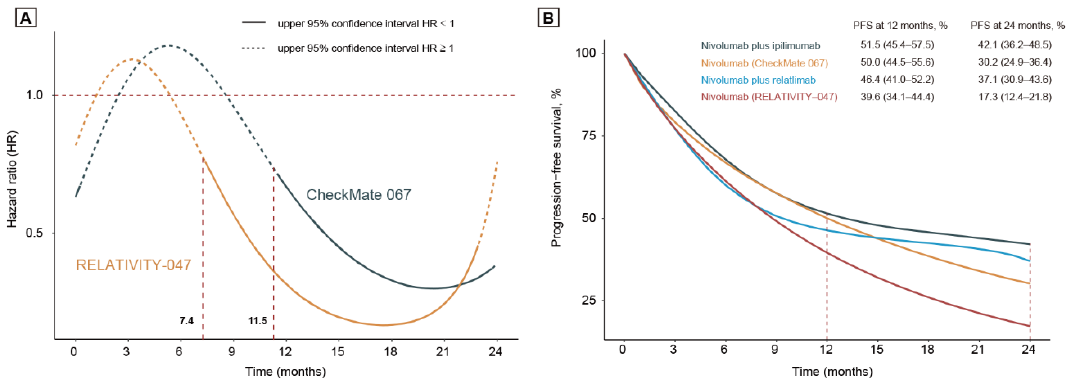
Figure 3. Bayesian Hierarchical Survival Model. ( A ) The time-varying HR is based on the Bayesian hierarchical model. The dotted line indicates that the upper limit of the confidence interval of estimated HR is higher than 1. ( B ) Posterior means of PFS of the treatment arms of CheckMate-067 and RELATIVITY-047 trials. Abbreviations: HR, hazard ratios; CI, confidence interval; RMST, restricted mean survival time.